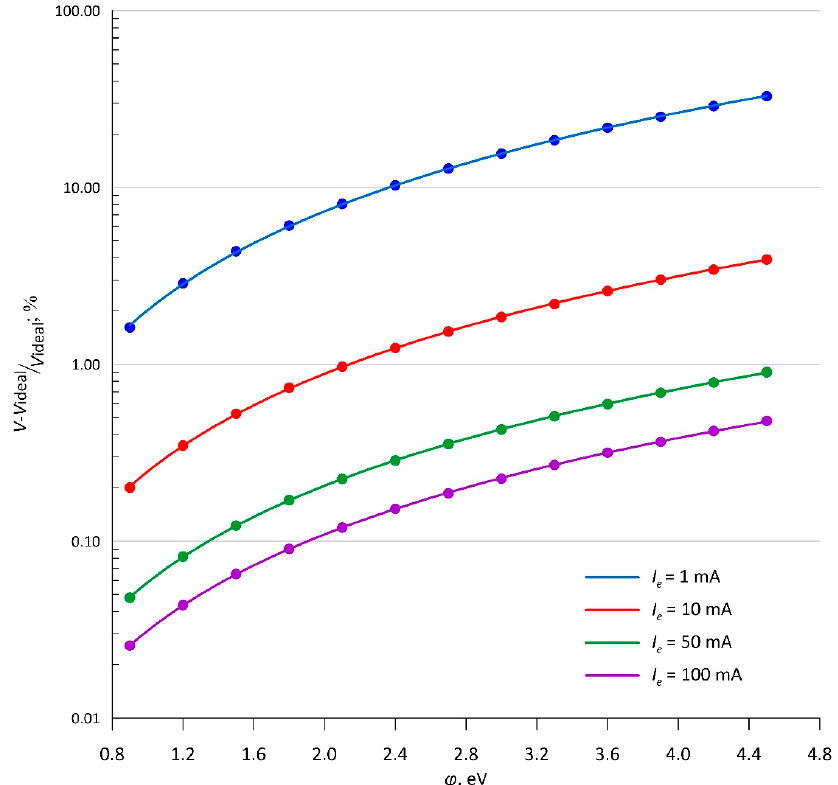
Figure 3. The simulation results of the relative voltage difference ( V − V ideal )/ V ideal ) as a function of the cathode electron work function, for the set values of the emission current. The analysis of the results shows that the described I e - V conversion method in the cathode power supply circuit is predestined for electron sources with low electron work function of the cathode material. For a fixed electron work function, the relative voltage difference decreases with the increase of the emission current. An important design issue is the selection of sensing resistors with high temperature stability, because a relatively high cathode current flows through them, which causes their heating. 3. Experimental Results 3.1. Dynamic Parameters of the Electron Source with Sensing Resistors Connected in Series in the Cathode Supply Circuit In order to assess the influence of the sensing resistors on the dynamic properties of the thermionic electron source, the time constant T c and the delay time T 0 were determined using step response method [13]. The scheme of the measuring system is presented in Figure 4. The square wave control signal is fed from the Ao1 output of the NI 6251 data acquisition card to the input of the power amplifier A1 operating in a voltage follower configuration, the output of which is connected to the cathode power supply circuit and the input Ai0. The voltage, directly proportional to the emission current intensity, is sup- plied to the Ai2 input from the I e -V anode converter built on the basis of the current mirror [7].